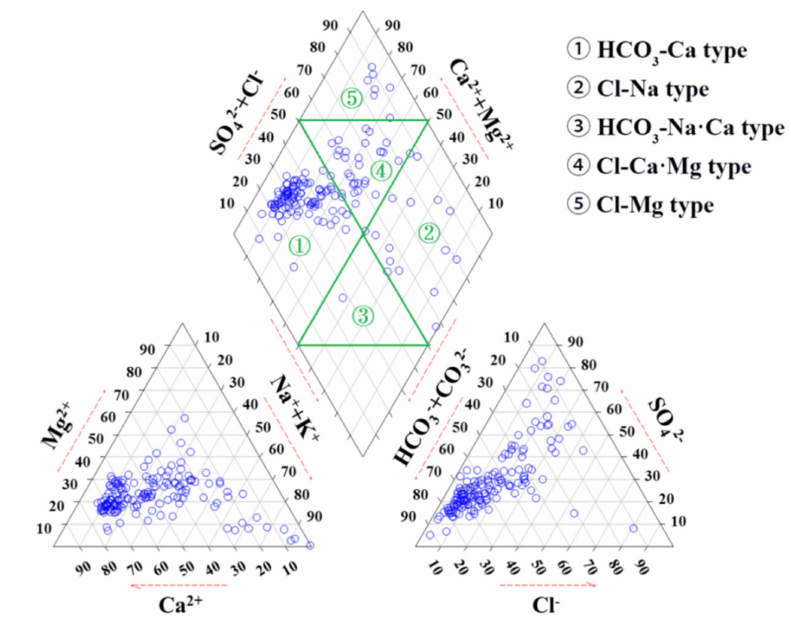
Figure 5. Piper diagrams of groundwater in Huangshui River basin.